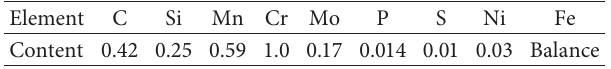
Table 1: Ingredient of AISI 4140 steel (%, mass fraction).